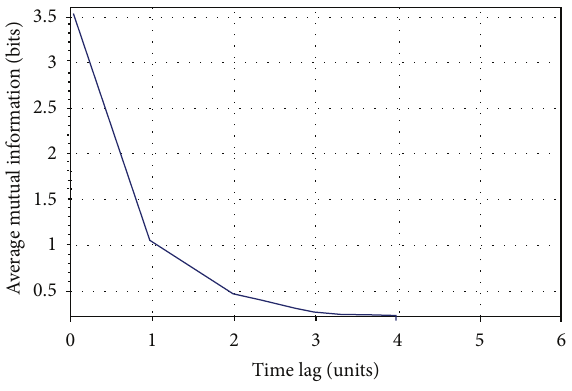
Figure 5: Calculated process of optimal time delay.